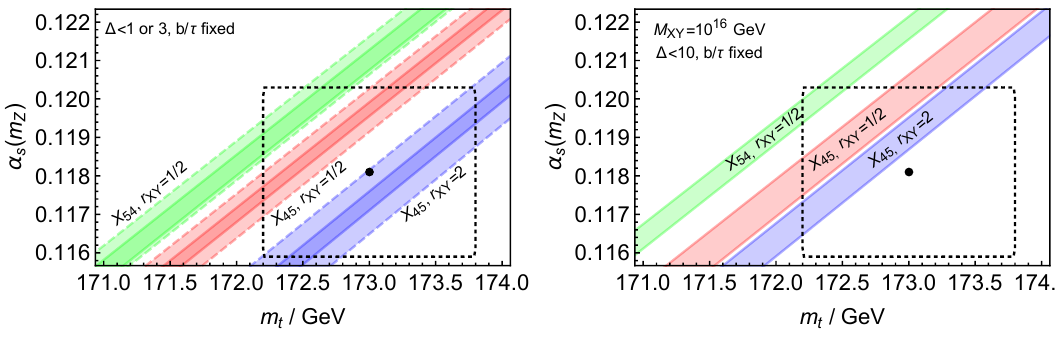
Figure 7 . Predicted correlation between the top quark mass m t and the QCD coupling (cid:11) s ( m Z ) in three 3221 models (left panel); with M XY constrained (right panel). The dot and the dotted box show the central value and the 2 (cid:27) range of the observed values, respectively.